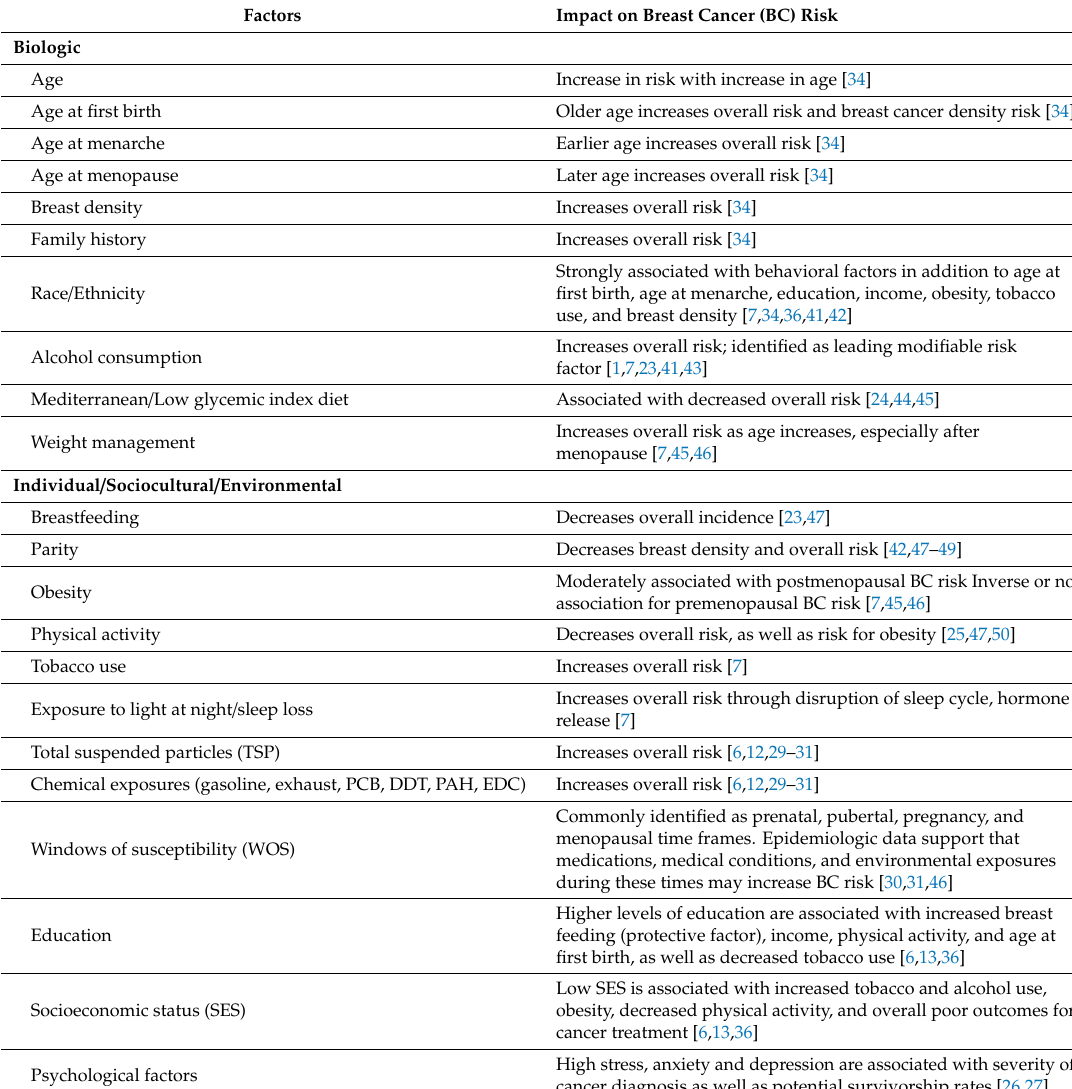
Table 1. Breast cancer risk